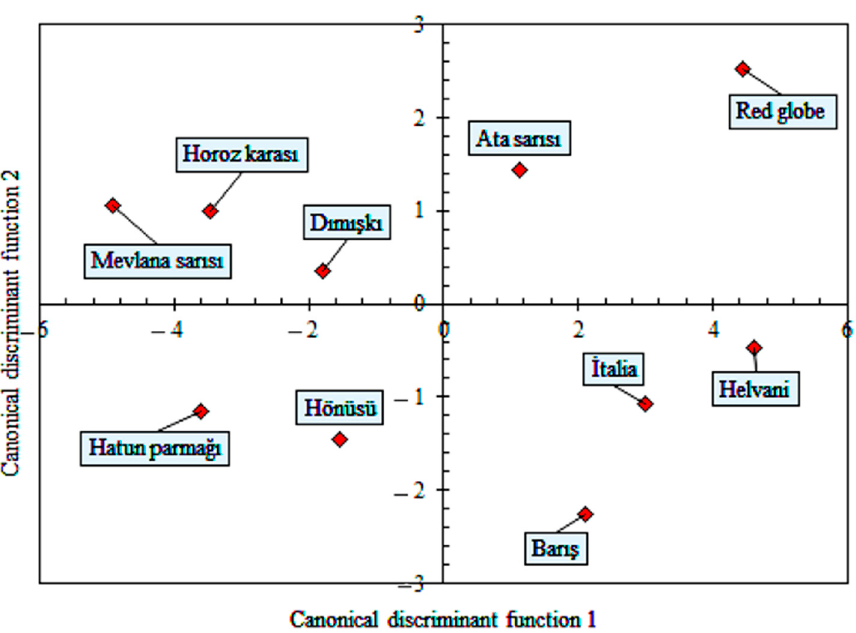
Figure 4. Biplot charts from the linear discriminant analysis of 10 grape varieties, based on the size and shape data, measured or calculated using image processing method.